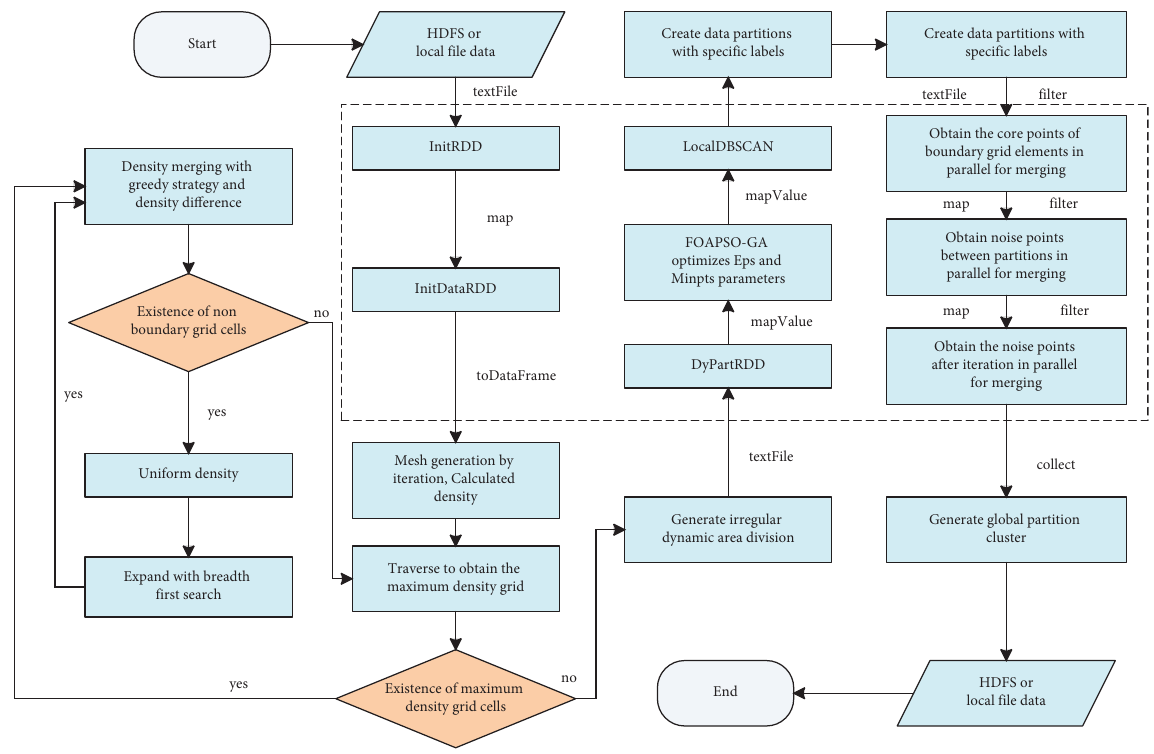
Figure 3: Flowchart of the proposed